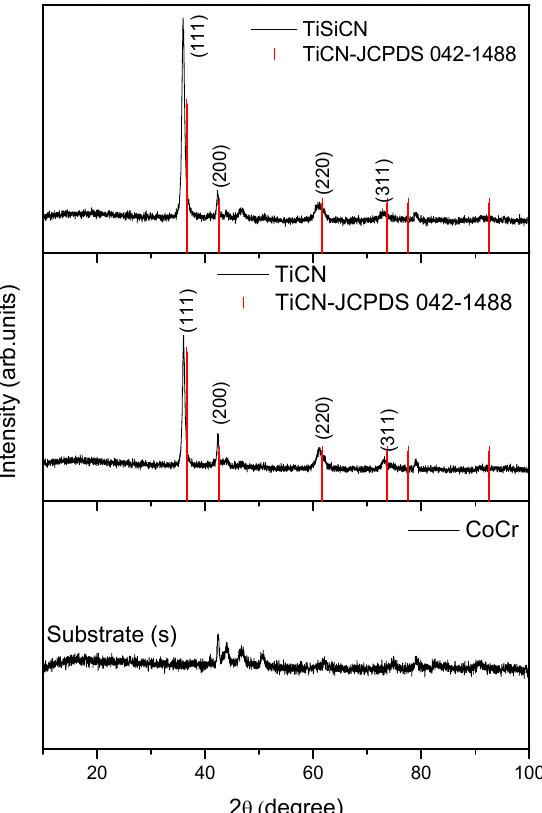
Figure 1. X-ray di ff raction patterns of the investigated coatings (S-substrate) as well as of the TiCN Figure 1. X ‐ ray diffraction patterns of the investigated coatings (S ‐ substrate) as well as of the TiCN standard (JCPDS standard (JCPDS 042 ‐ 1488).